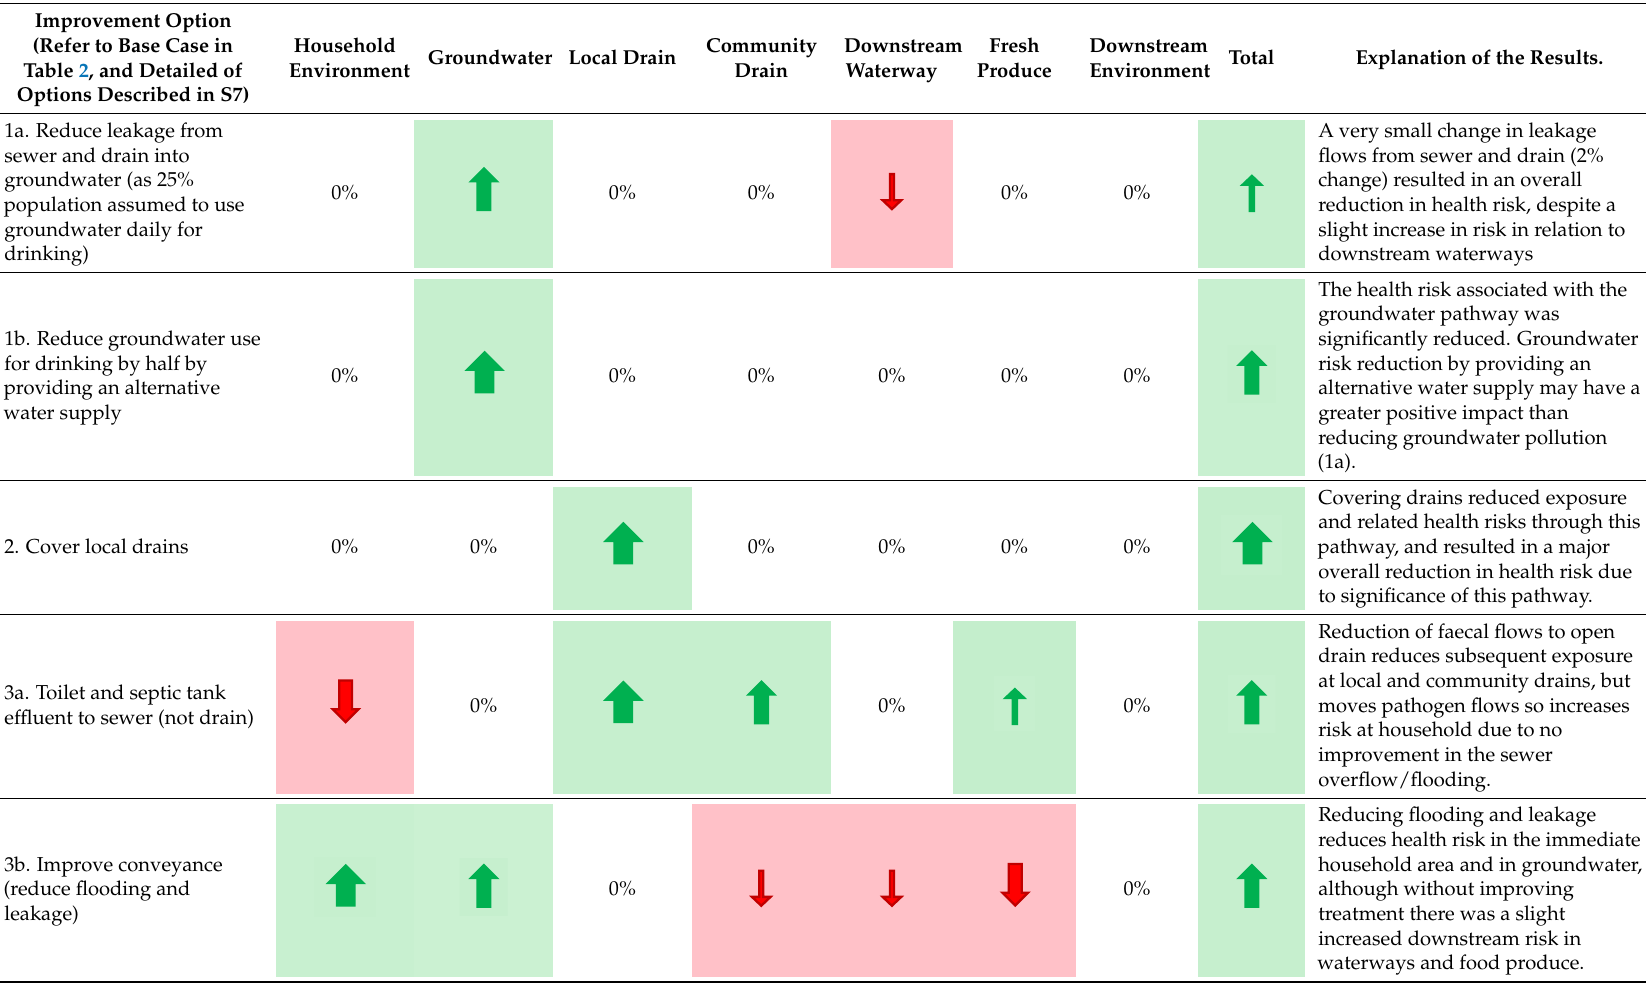
Table 3. Change in DALY per person per day from base case (based on exposure frequency and proportion of population exposed for Adults). Improvement Option (Refer to Base Case in Table 2,